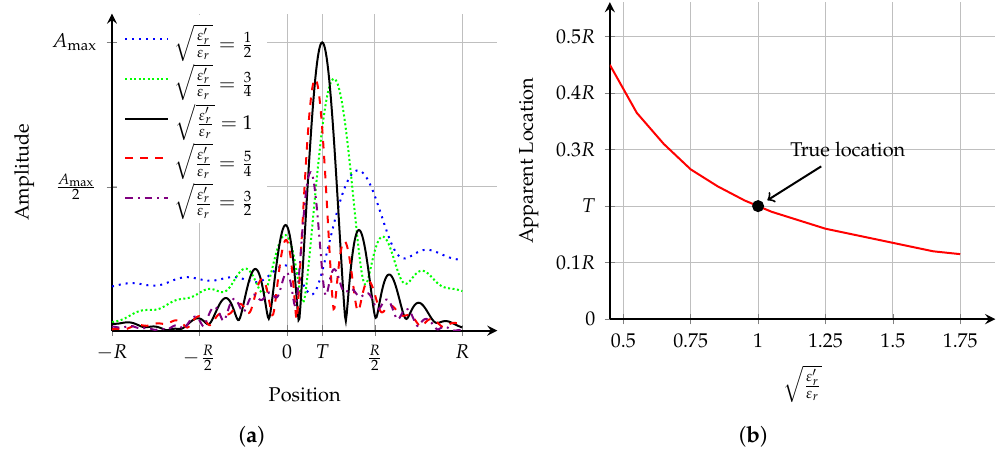
Figure 3. The theoretical point spread function (PSF) is analysed here. ( a ) shows the one-dimensional (cid:113) ε (cid:48) r PSF for various values of . Localisation error increases as the difference between ε (cid:48) r and ε r grows. ε r (cid:113) ε (cid:48) r The number of sidelobes decreases as decreases; ( b ) shows the apparent location of the scatterer ε r (cid:113) ε (cid:48) r as varies; As the effective average dielectric properties are overestimated ( ε r location is closer to the centre (0) compared to the true location. As the effective average dielectric (cid:113) ε (cid:48) r < 1), the apparent location is closer to the skin ( R ) compared to properties are underestimated ( ε r the true location. In both ( a , b ), the true location is at T = 0.2 R